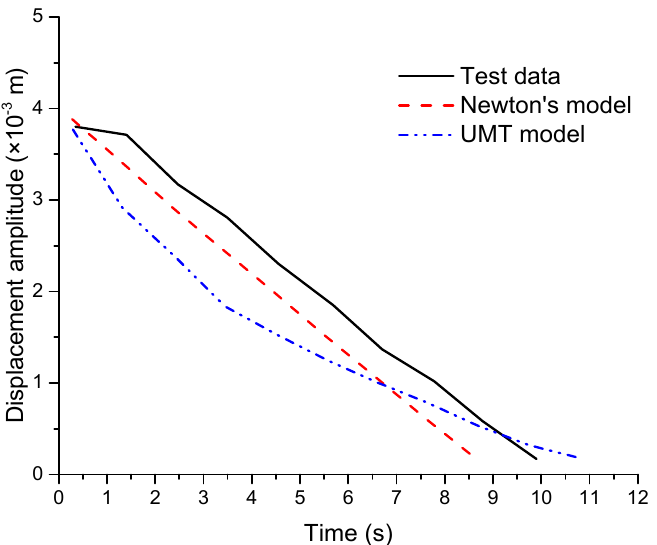
Figure 9. Comparison between the model predictions and test data [47] for the amplitude versus time data